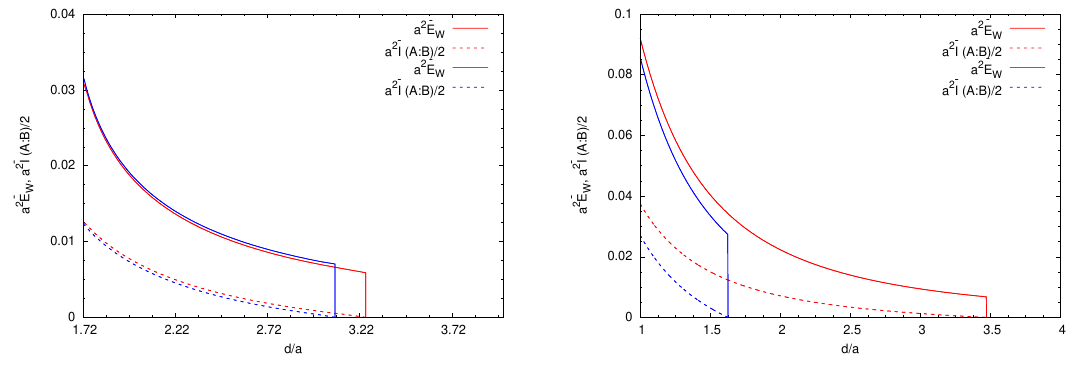
π = 5 . 0023 for aT = 0 . 1 , and a π